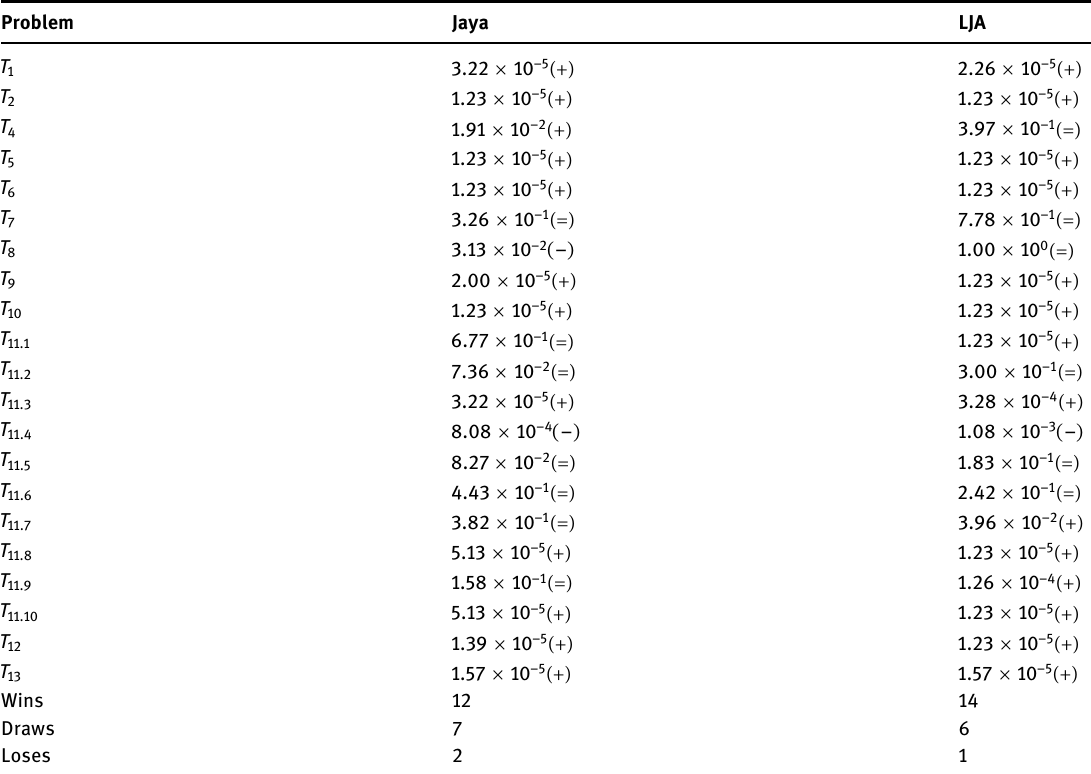
Table 8: The CEC 2011 statistical analysis showing the Wilcoxon test p - value